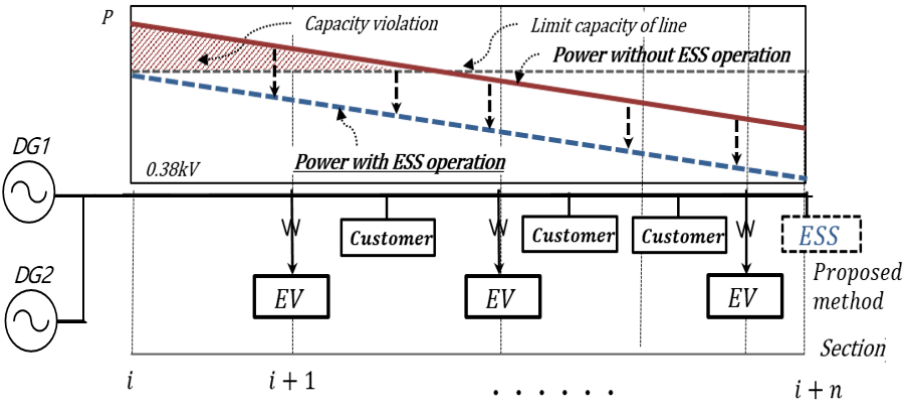
Figure 2. Voltage regulation by the bidirectional power flow in MG.